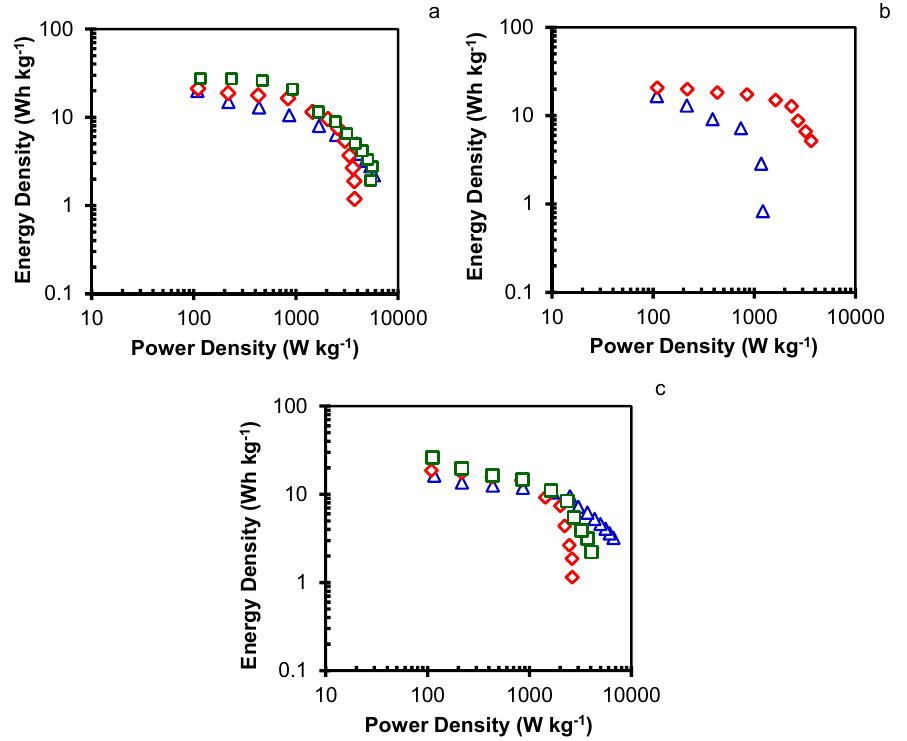
Figure 4. Ragone plots of samples ( a ) MA1 ( △ ), MA2 ( ◇ ), and MA3 ( □ ); ( b ) CMA2 ( △ ), and CMA4 ( ◇ ); and ( c ) HMA100-2 ( △ ), HMA150-2 ( ◇ ), and HMA200-2 ( □ ). Table 5. Energy density (Wh · Kg − 1 ) at 110 W · kg − 1 from Ragone plots. Sample